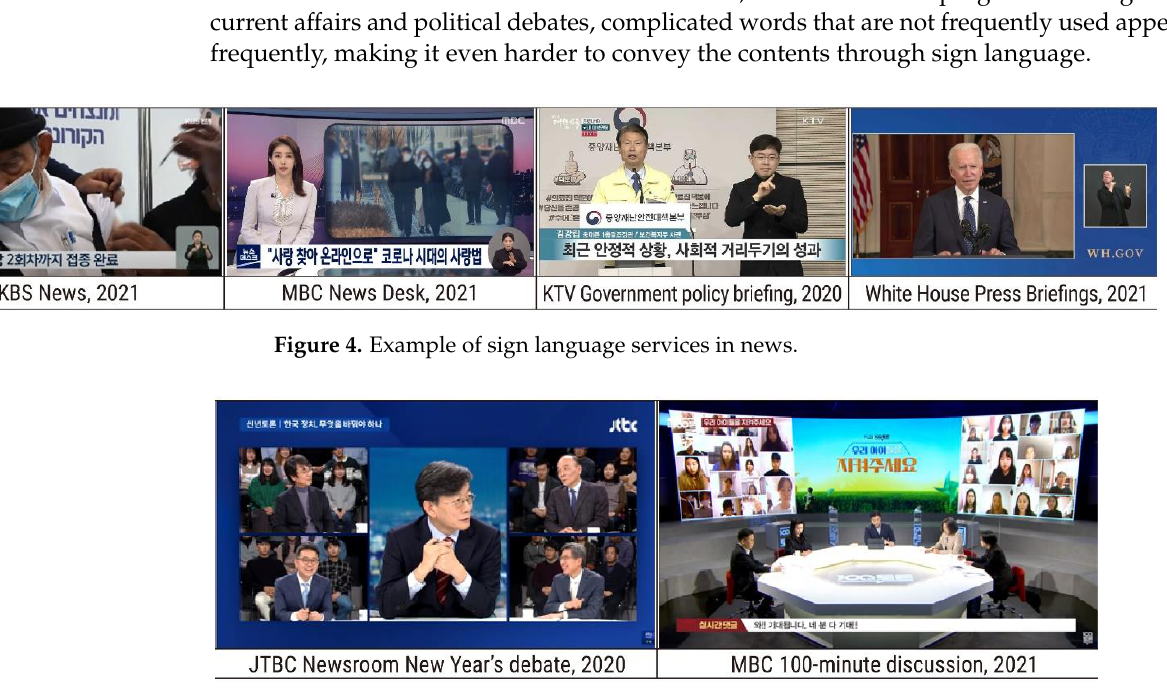
Figure 3. Example of news type broadcasts. Translation of subtitles – Left: “Group infection at Noryangjin Fish Market… Around 500 new confirmed cases” . Right: “Shooting at a middle school in Idaho… 3 people were injured” .